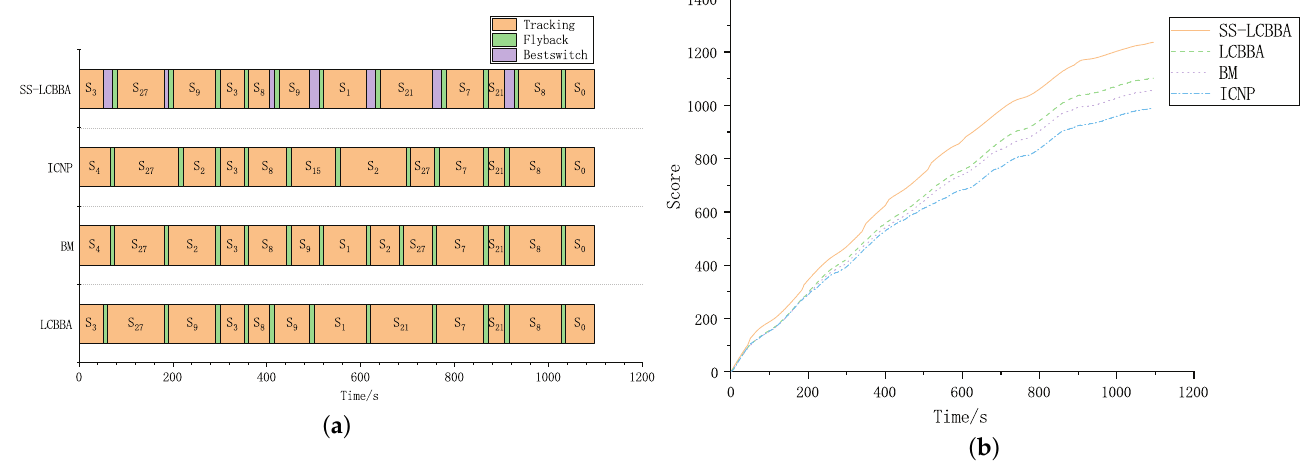
Figure 14. The planning results of tracking trajectory 2: ( a ) is a Gantt chart comparing the planning results and ( b ) is the cumulative tracking score of the value function.